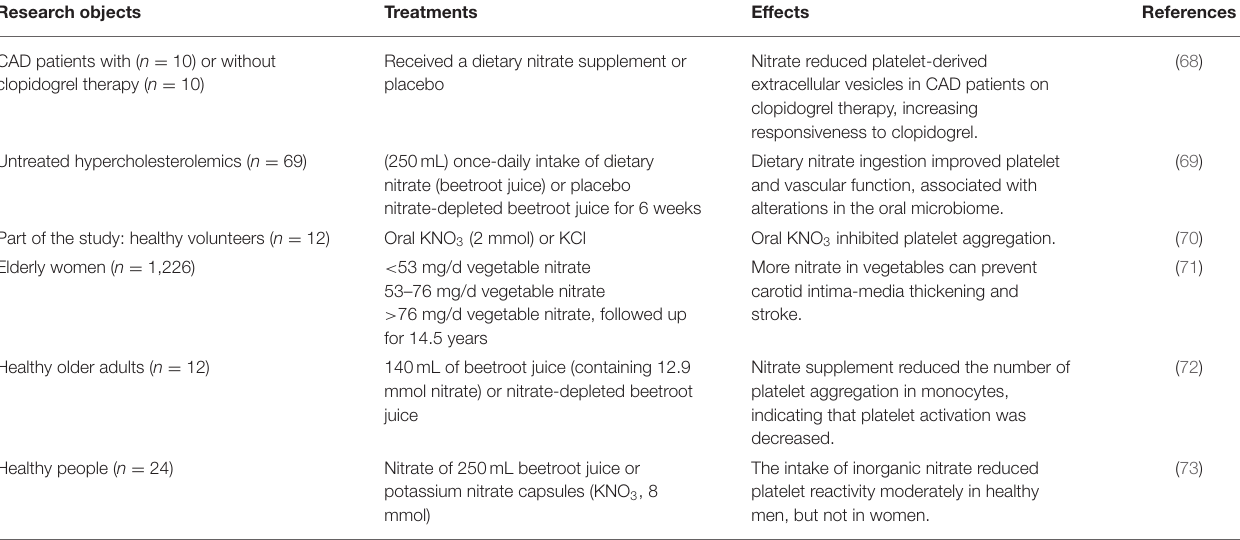
TABLE 1 | The effect of nitrate/nitrite on platelet aggregation in humans. Research